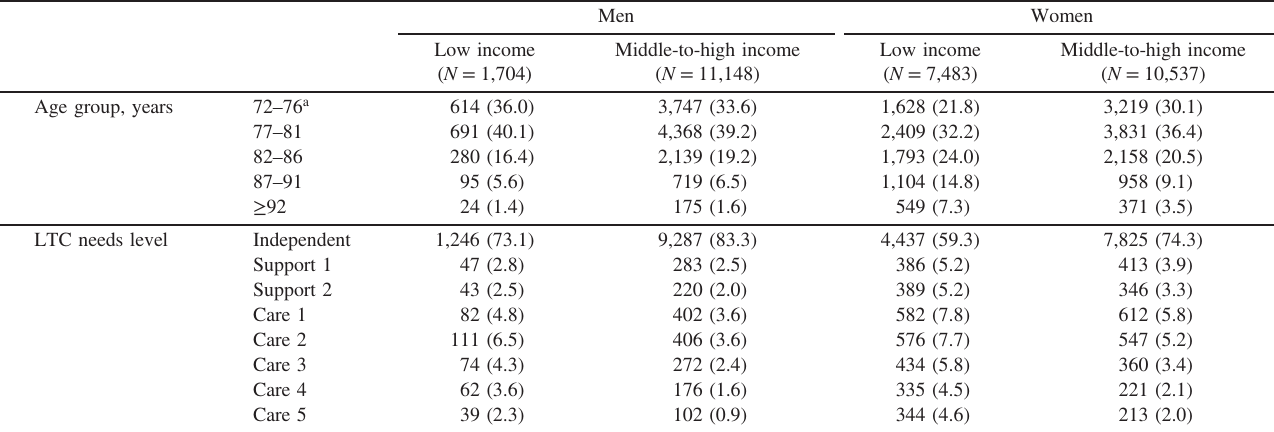
Men Women Low income Middle-to-high income ( N = 1,704) ( N = 11,148)